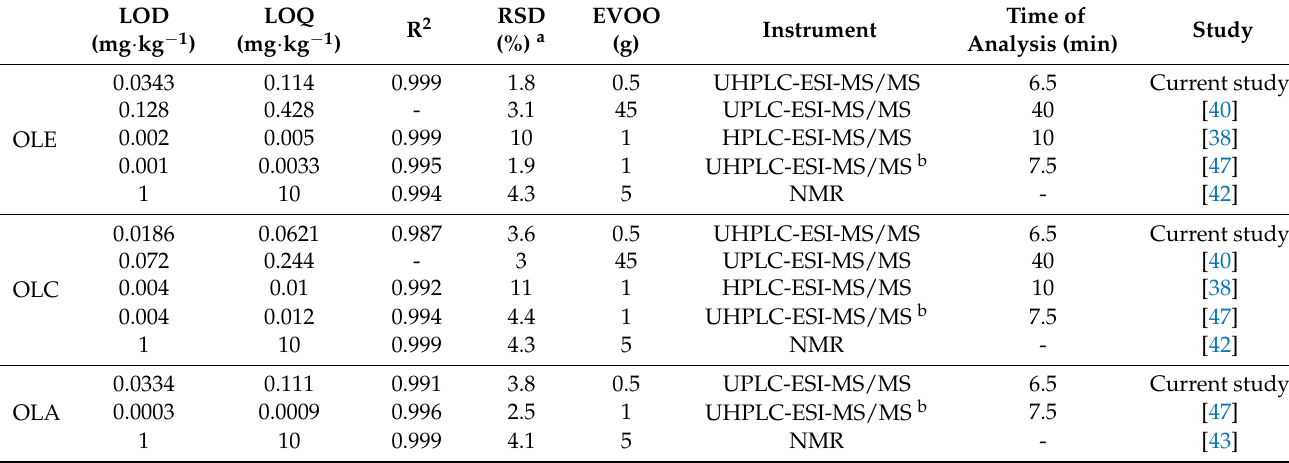
Table 3. Parameter comparison between methods for oleacein (OLE), oleocanthal (OLC) and oleuropein aglycone (OLA). LOD (mg · kg − 1